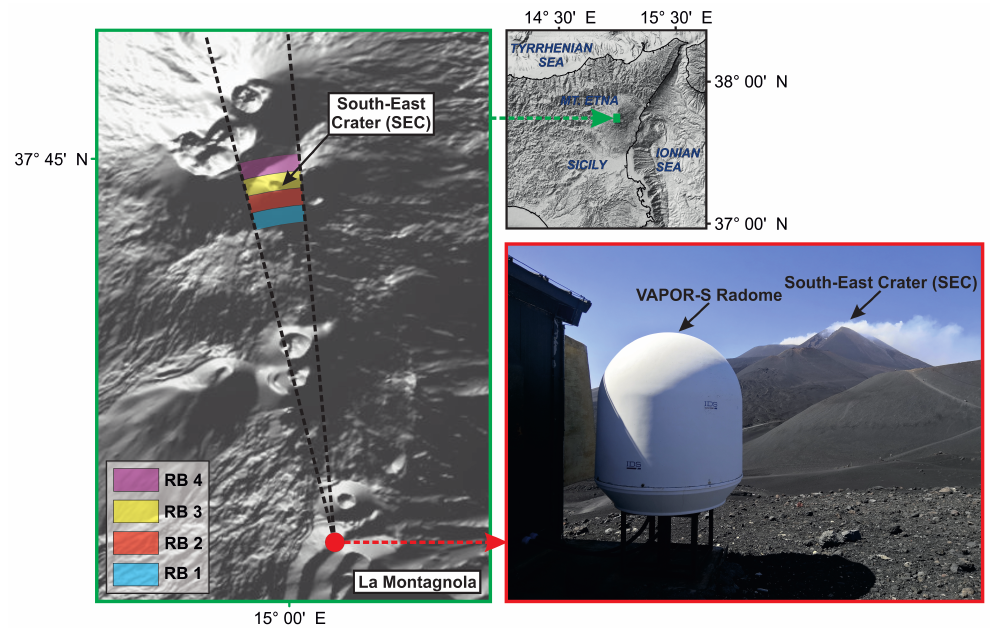
Figure 1. VAPORS-S location on Mt. Etna. On the left side, the radar beam aperture is shown as well as the sensed volume divided into four regions of interest, namely range bins (RBs). RB 1: 2850–3000 m; RB 2: 3000–3150 m; RB 3: 3150–3300 m; RB 4: 3300–3450